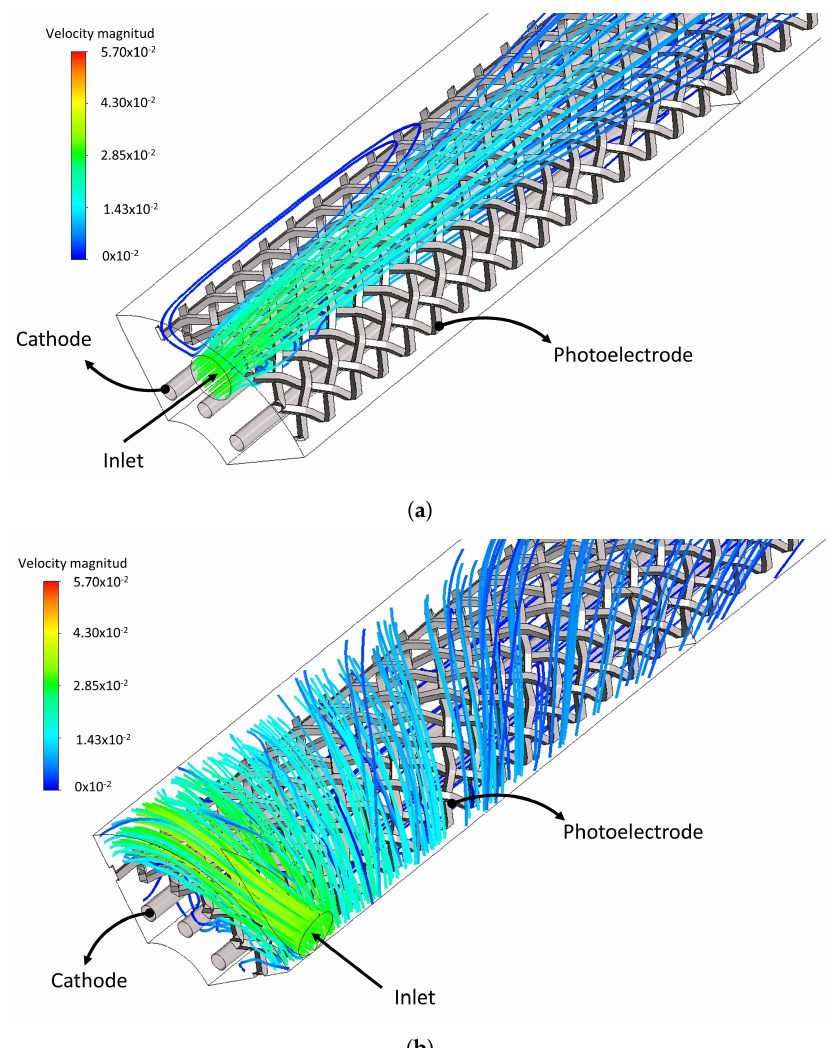
Figure 9. Streamlines for ( a ) AF and ( b ) TF in laminar